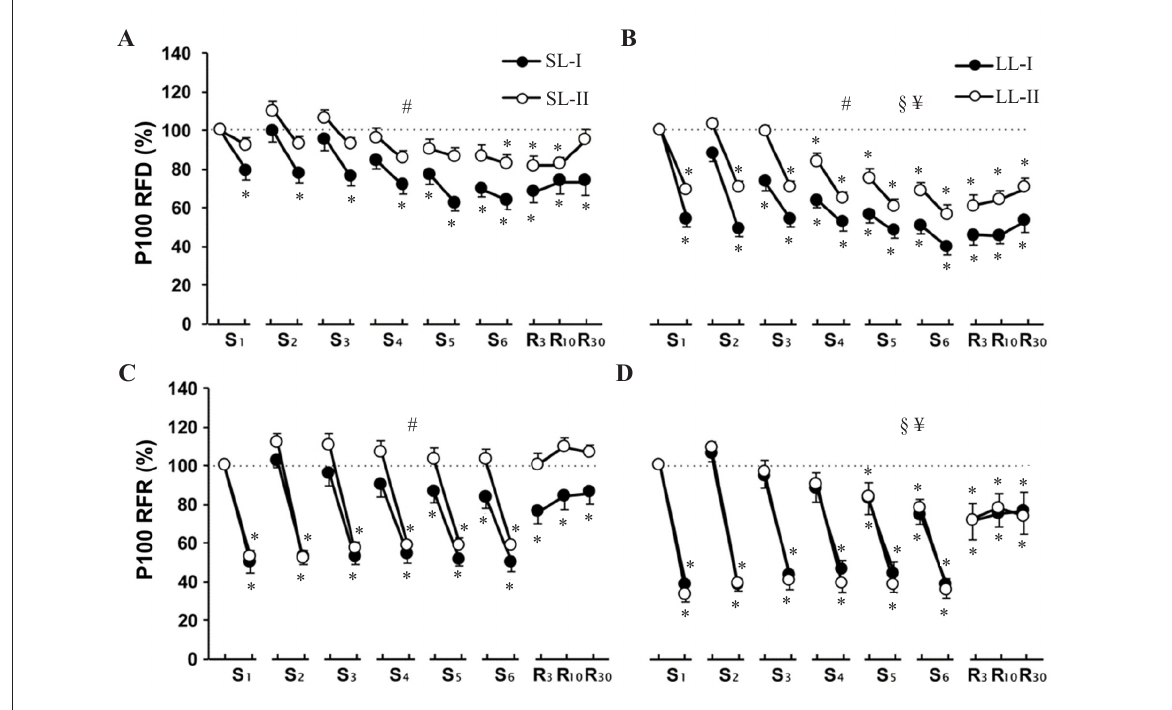
Figure 4. Electrostimulation results after each series of sustained maximal (uni-)bilateral contraction